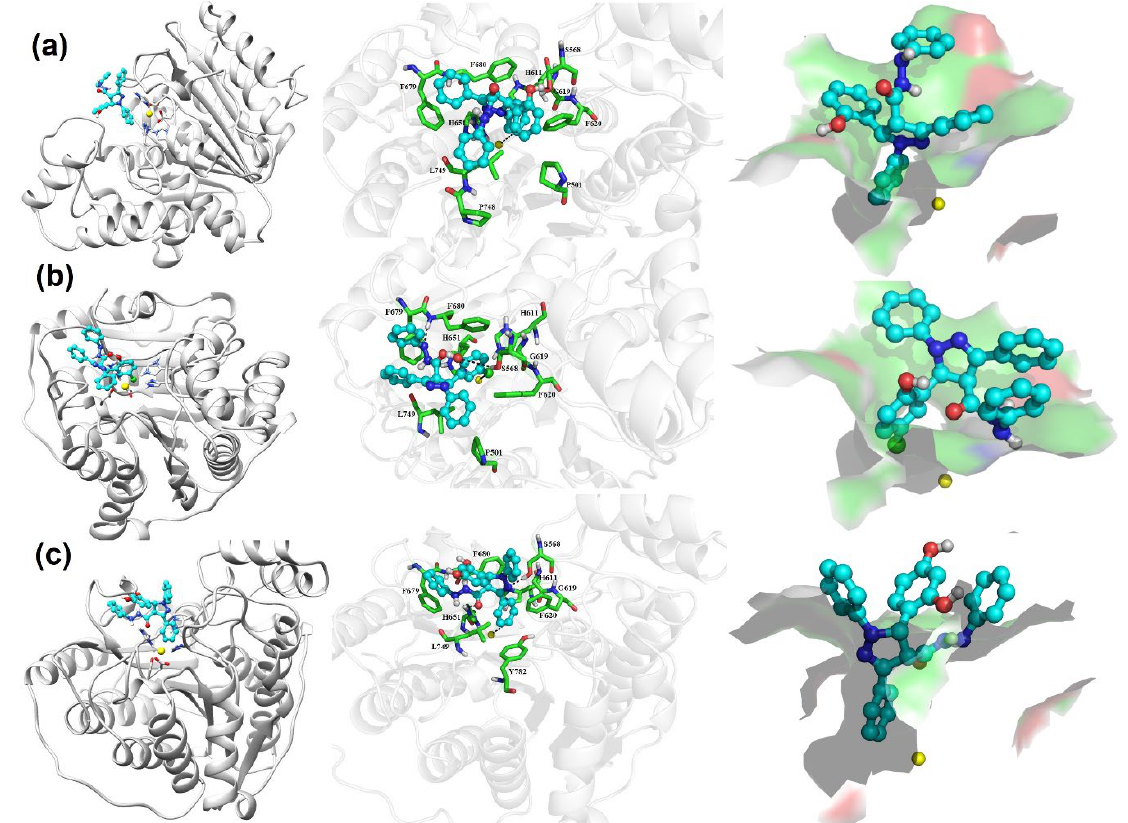
Figure 4. Binding poses at DD2-HDAC6 catalytic domain obtained through blind docking of the target compounds. Compounds: ( a ) 2a , ( b ) 2b , and ( c ) 2e ; Zn 2+ is depicted as yellow sphere. In the left panel, HDAC6 is depicted in white cartoon; in the middle panel, a zoom of the catalytic domain is shown where the AAR are as sticks, and the ligands are shown using a ball and stick representation; in the right panel, a surface representation of the catalytic tunnel is depicted in gray where the insertion of the N-Ph ( a ), C5-PhOH ( b ), and C3-Ph ( c ) rings are appreciated. Figures were built with Pymol and UCSF Chimera software.